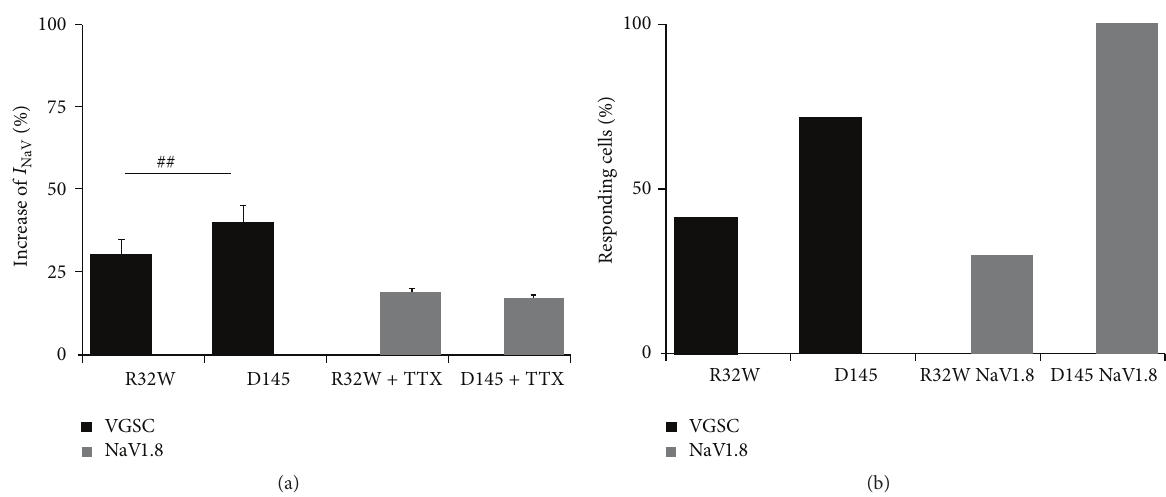
Figure 3: (a) Increase in 𝐼 Na ( V ) (10pg of each drug) and 𝐼 Na ( V 1.8) (100pg of each drug) currents after application of R32W or D145 during repetitive depolarization to 0mV after 600 s when the current reaches a steady state ( ## 𝑝 < 0.01 ). (b) Amount of responding cells, including 𝐼 𝐼 Na ( V ) or Na ( V 1.8) , in the cell population. Cells were classified as responding cells if the currents were affected by more than